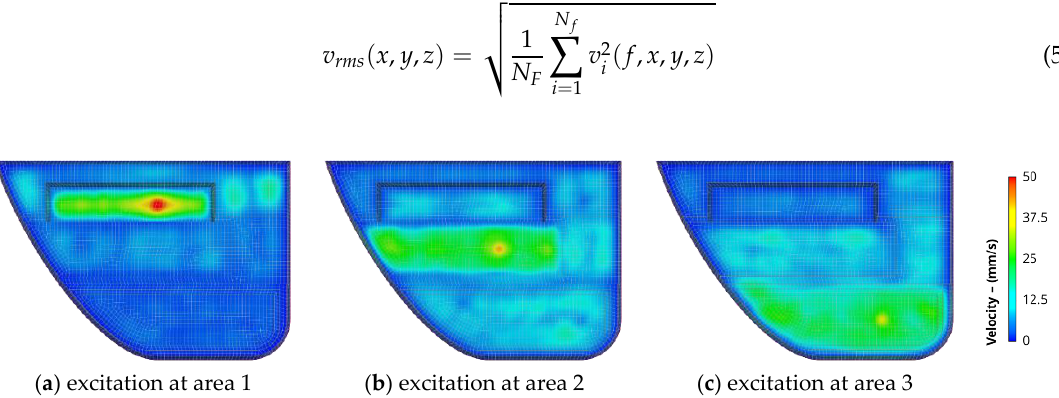
Figure 3. Surface velocity in the frequency range of 500 Hz to 5 kHz according to Equation (4) at three possible excitation locations: ( a ) area 1, ( b ) area 2, and ( c ) area 3.